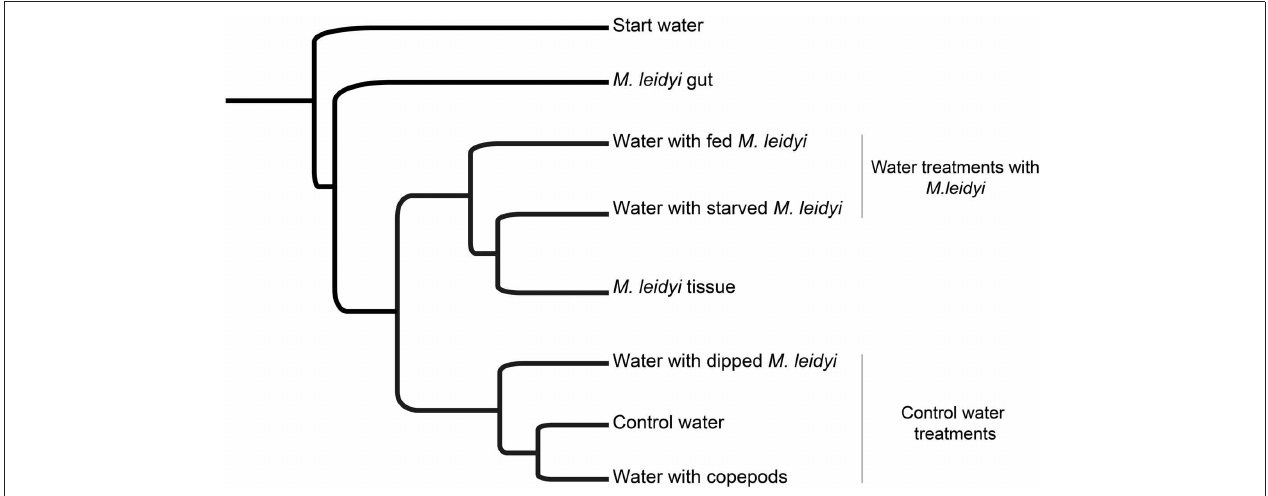
FIGURE 2 | UPGMA tree calculated from the Jackknife-weightedUniFrac distance matrix, displaying the phylogenetic distances between samples (based on the subsampled datasets of 1043 sequences).